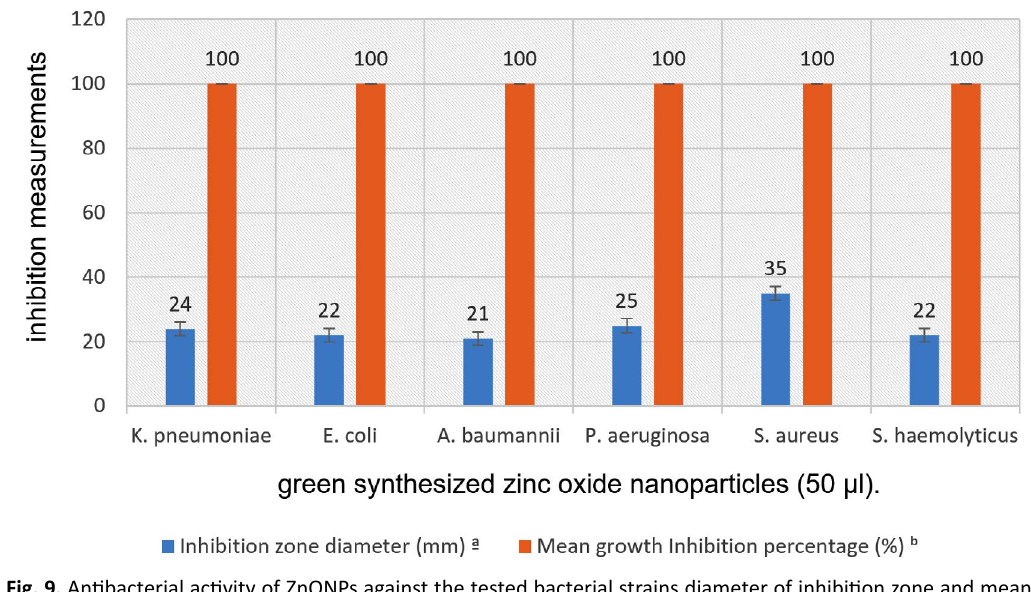
Fig. 9. Antibacterial activity of ZnONPs against the tested bacterial strains diameter of inhibition zone and mean growth inhibition